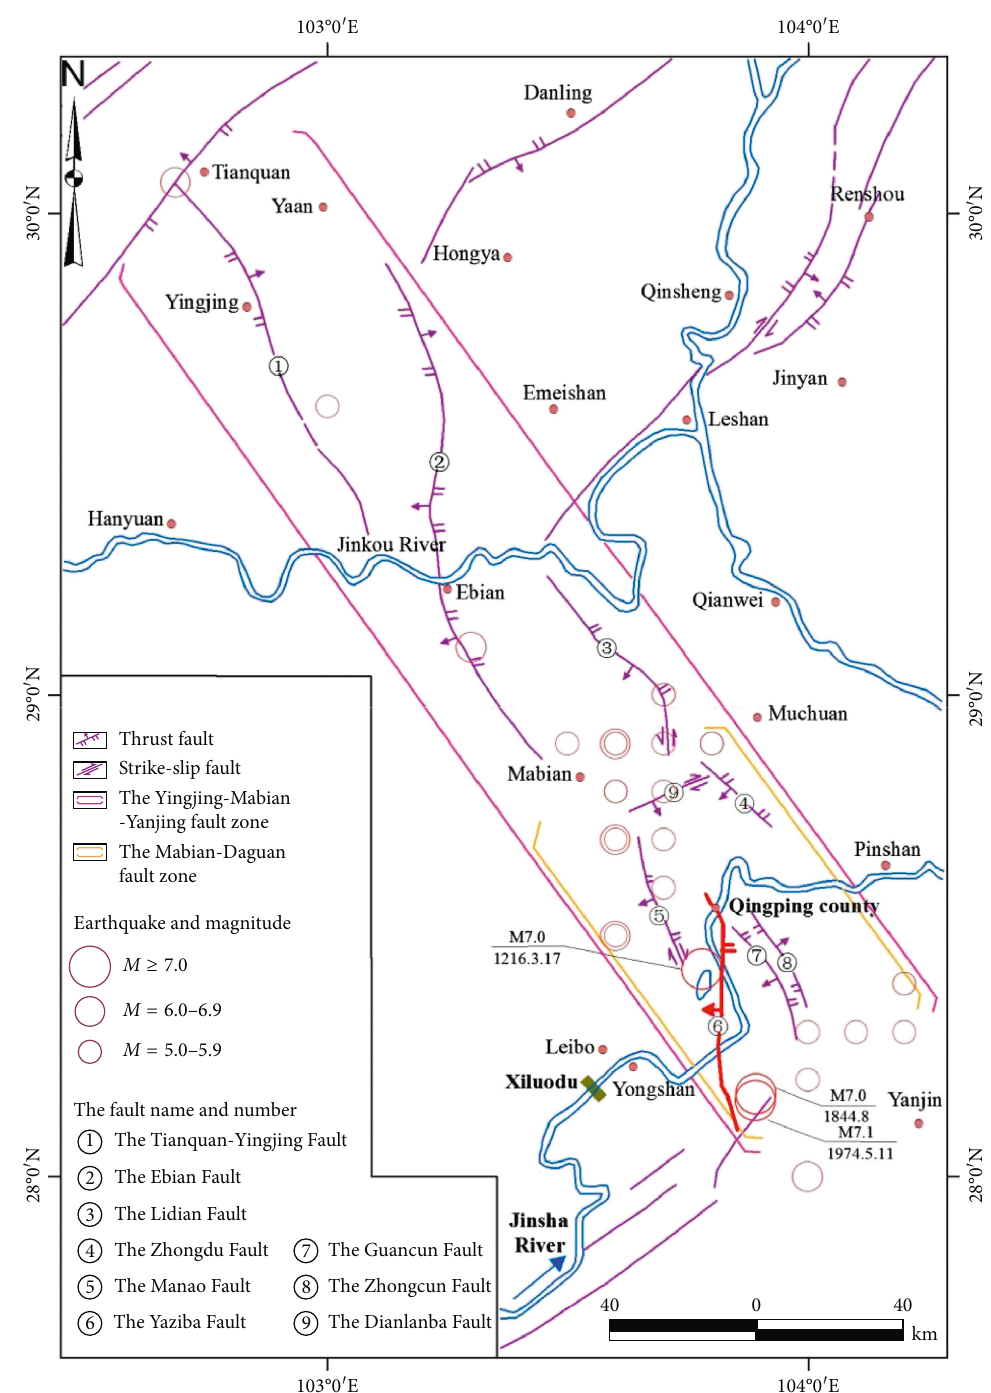
Figure 2: Map showing the locations of the Yingjing-Mabian-Yanjing fault zone and the Yaziba